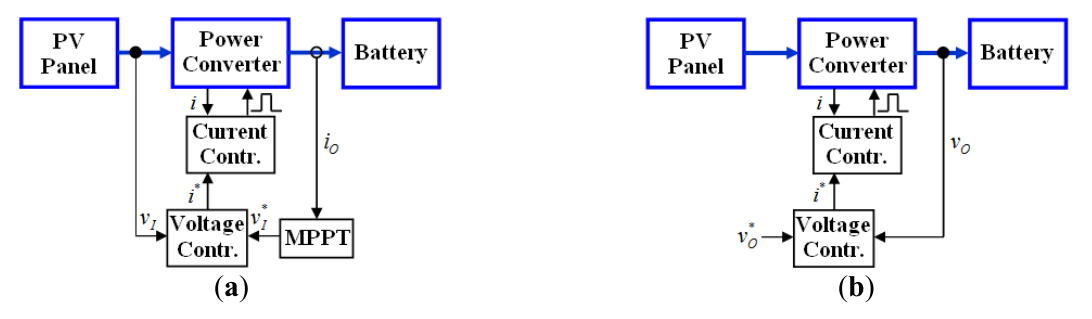
Figure 3. Control structure of ( a ) constant power (CP) mode; ( b ) constant voltage (CV) mode.